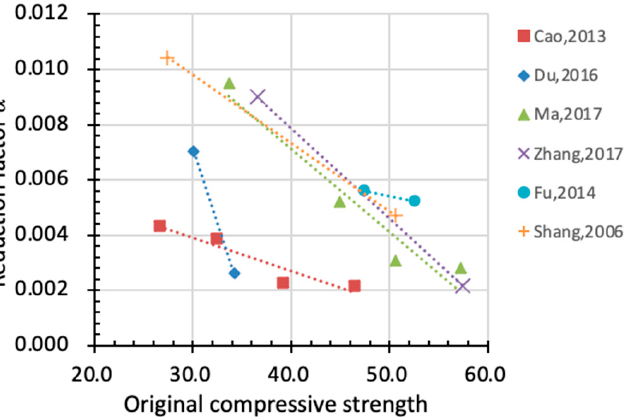
Figure 20. Relationship between original compressive strength and reduction factor α (x-axis: original compressive strength, y-axis: factor α ).